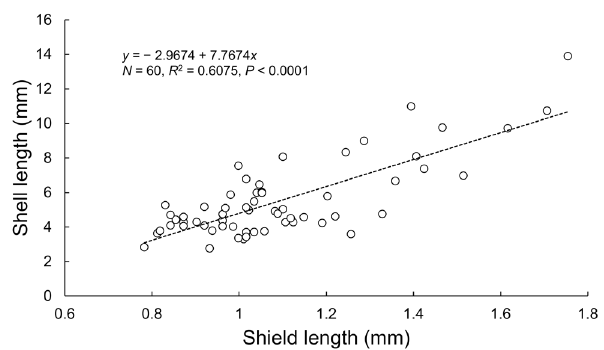
Figure 3. Relationship between shield length of early juvenile land hermit crabs and length of gastropod shells occupied by the crabs in the 2015